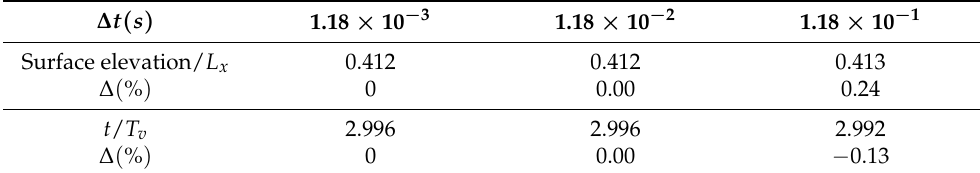
Table A11. Time step sensibility analysis for the nonlinear regime: maximum value of surface elevation/ L x , its time location t / T v , and their relative difference compared to ∆ t ( s ) = 1.18 × 10 − 3 s for EbFVM S